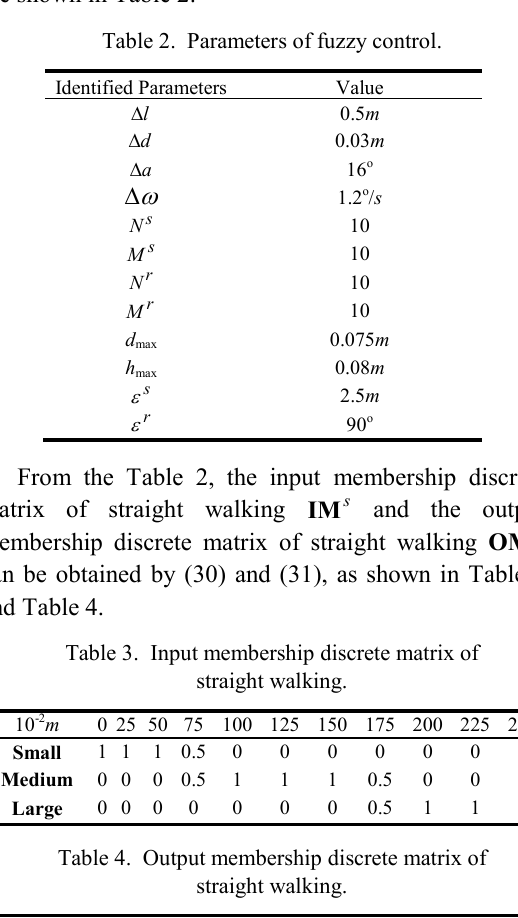
Fig. 13. Step length results under fuzzy control.